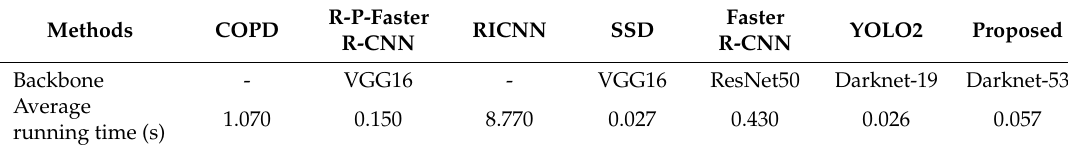
Table 6. The average testing time of compared object detection